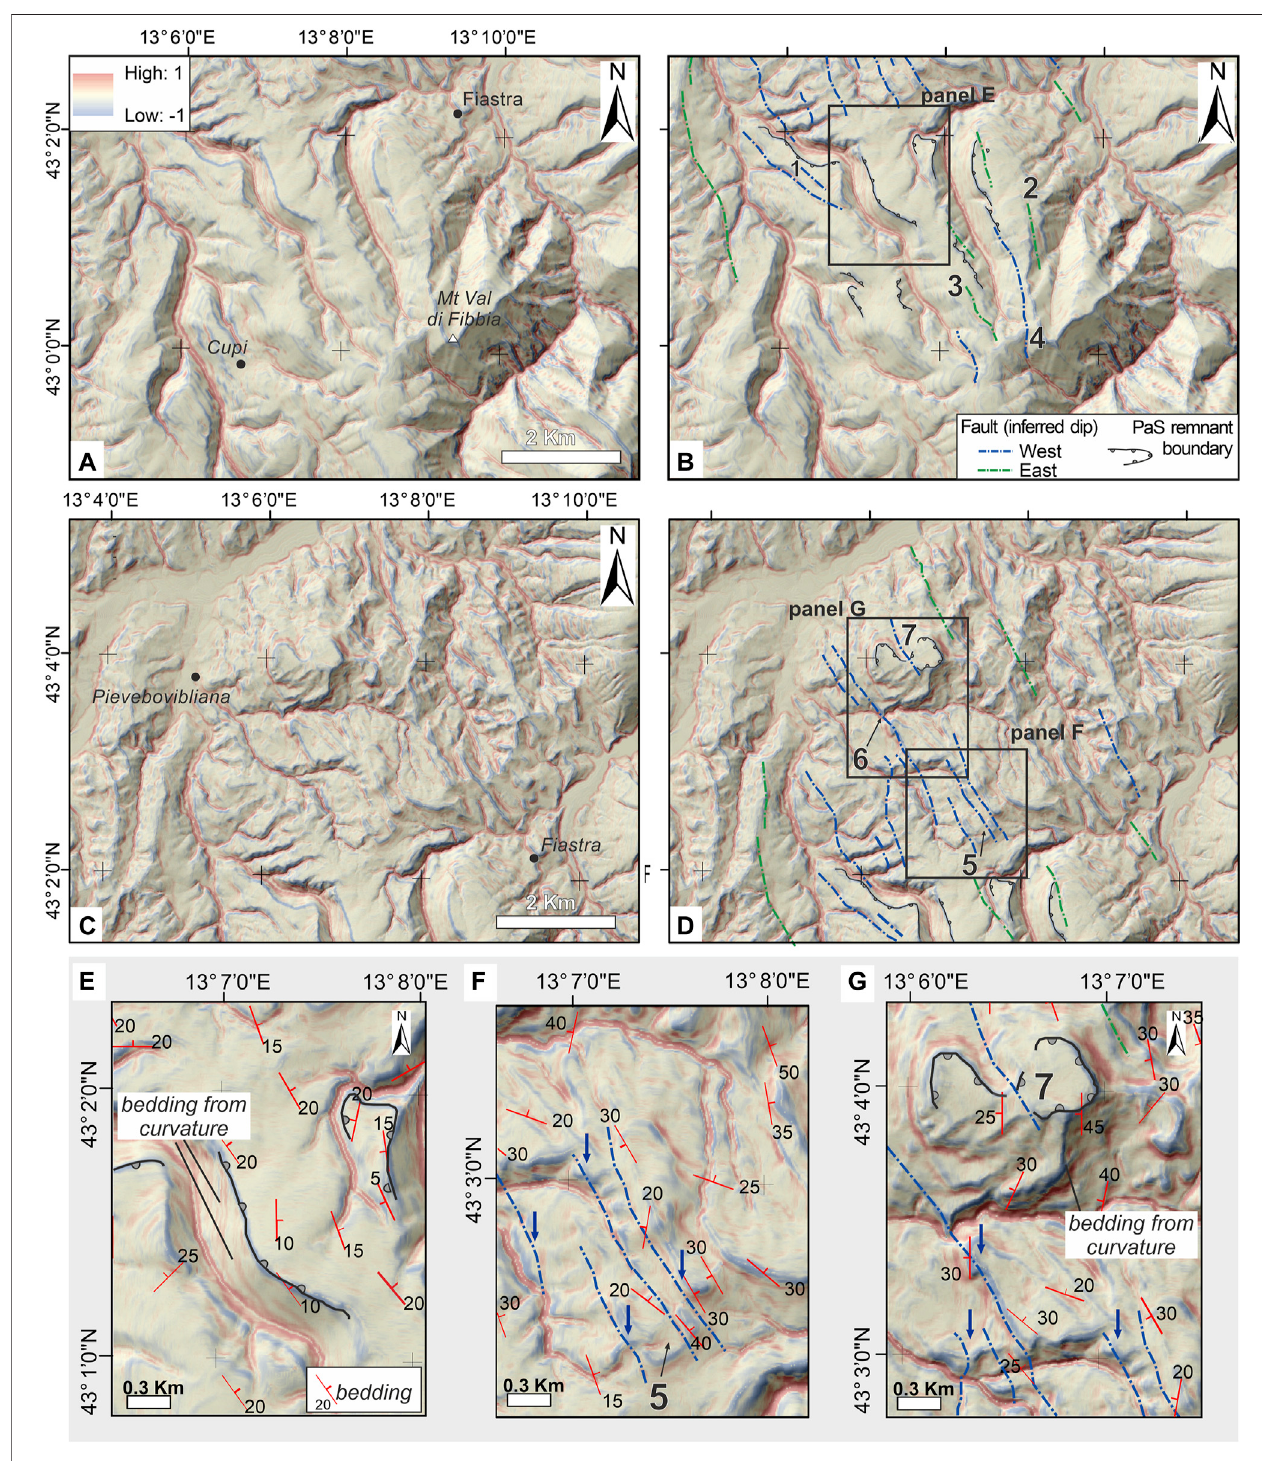
FIGURE4| Resultsofthecurvatureanalysisinthestudyareasdiscussedinthetext(insetsbandcin Figure1B )withinterpretedlineamentsandkeycriteriausedin interpreting the maps. (A) Pro fi le curvature map in the Cupi-Mt Val di Fibbia sector. (B) Pro fi le curvature map (same as in A) with the overlapping interpreted lineaments. (C) Pro fi le curvature map in the Pievebovigliana-Fiastra. (D) Pro fi le curvature map (same as in (C) ) with overlapping interpreted lineaments. Numbers 1 to 7 refer to the lineamentsdiscussedinthetext. (E) Detailonthepalaeosurfaceremnant(PaS)asinferredbythe(negative)curvaturevaluesde fi ningasurfaceboundarycuttingthe stratigraphy (see positive – red – pseudo-linear curvature values coinciding with the bedding. (F,G) Details on the breaks of rock bedding suggesting possible tectonic lineaments. Note in (G) also the offset of a fl at surface similar to PaS (point 7).